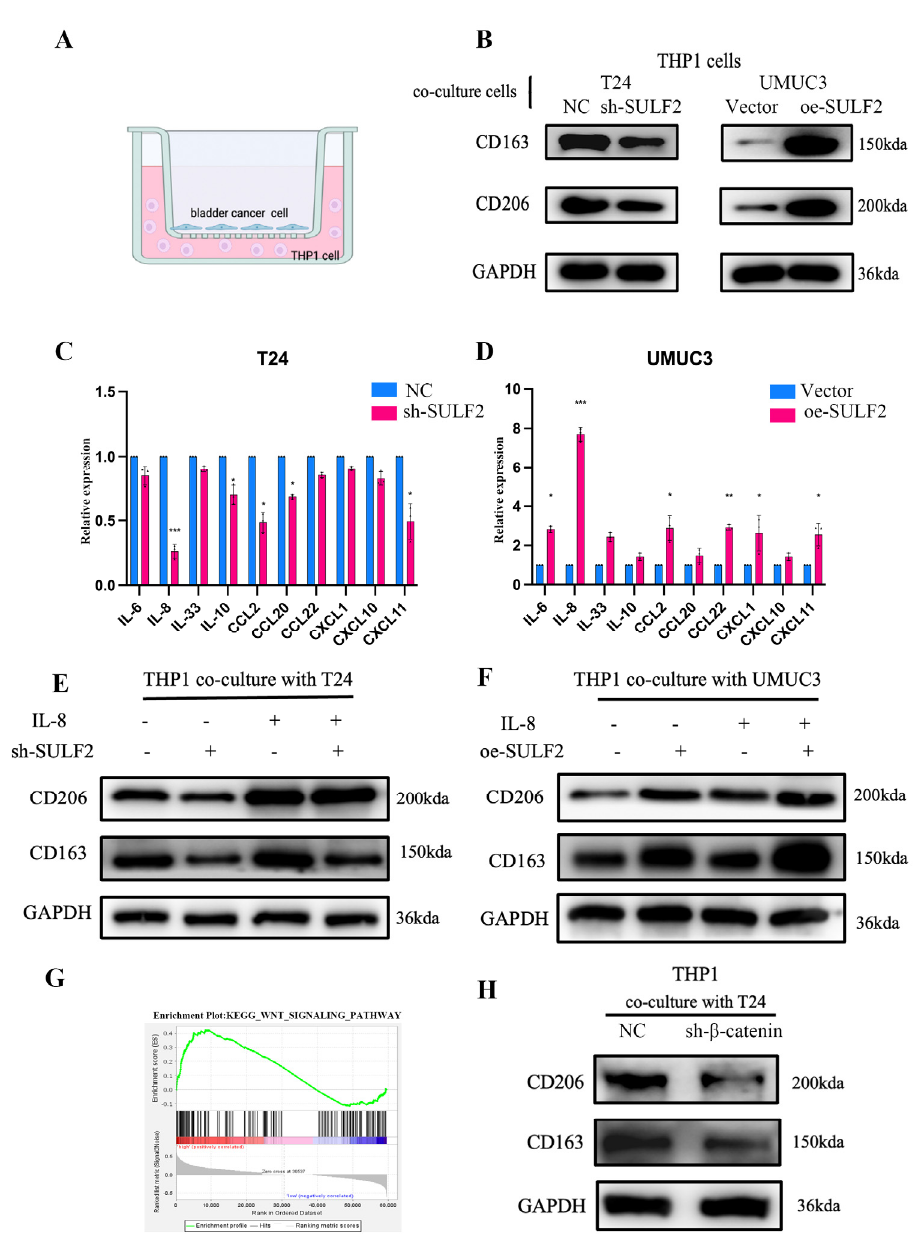
Figure 6. SULF2 promotes secretion of IL-8 through β -catenin. ( A ) An illustration of coculture of THP1 with BCa cells. ( B ) After coculture of THP1 with knockdown or overexpressing SULF2 cells, CD163 and CD206 expression in THP1 cells was detected by western blot. ( C , D ) Multifactor ELISA showed that knockdown or overexpression of SULF2 has most significant effect on IL-8 among other interleukins. ( E , F ) After exogenous addition of IL-8 to the coculture system, the expressions of CD163 and CD206 were detected by western blot. ( G ) GSEA analysis showed that SULF2 is significantly positively related to Wnt/ β -catenin. ( H ) After knockdown of β -catenin in the coculture system, the expressions of CD163 and CD206 were detected by western blot. Data are represented as mean ± SD of three experiments. * p < 0.05, ** p < 0.01, *** p <